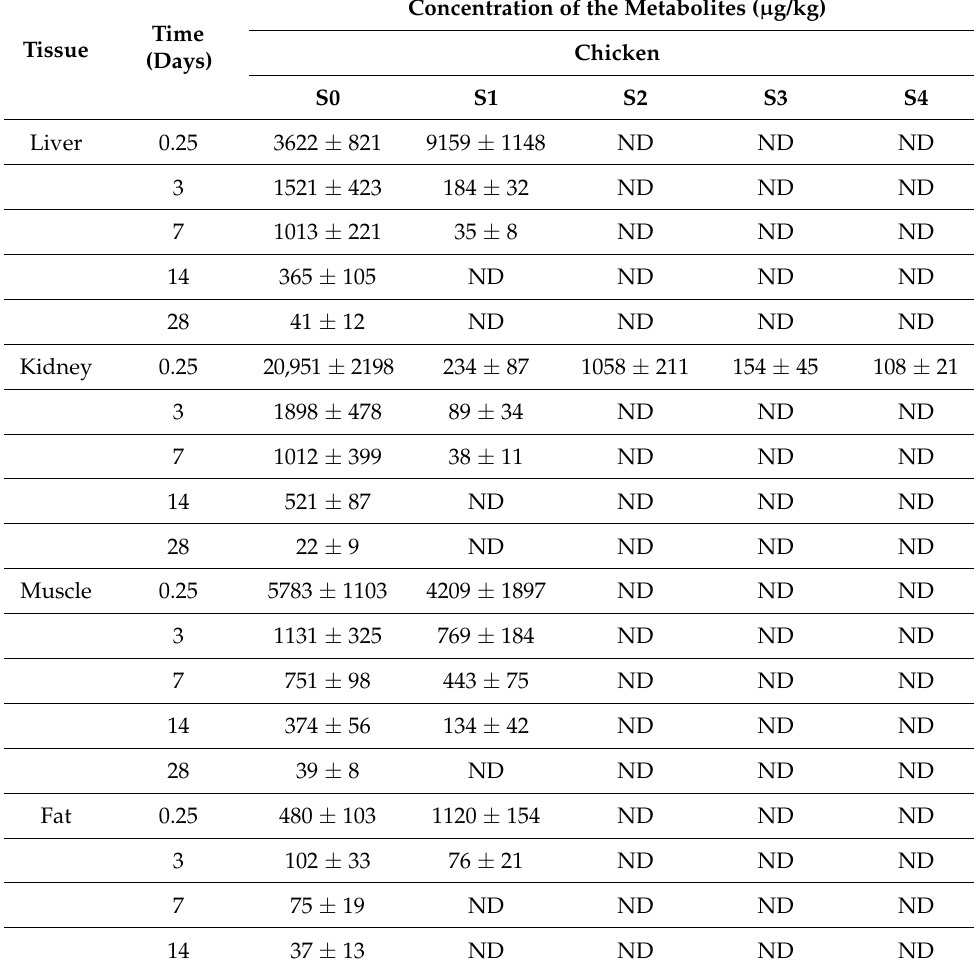
Table 5. Concentration of SMZ and its metabolites in tissues of